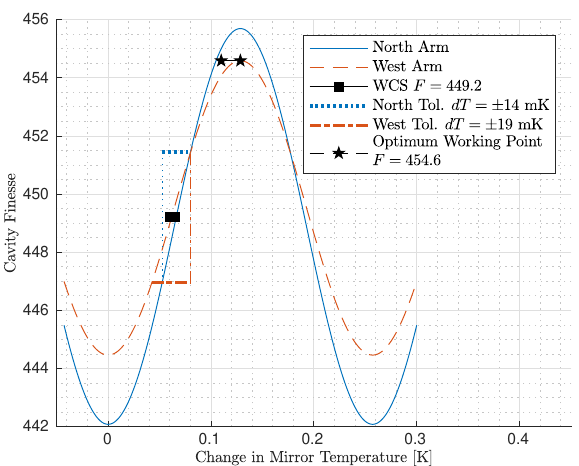
Figure 2. Finesse variation due to the etalon effect for the two arm cavities of Advanced Virgo. The temperature tolerance is calculated in the worst case scenario (WCS), where the slope of the curve is maximal. The reflectivity of the anti-reflective (AR) coating is 58ppm for the north arm and 32 ppm for the west arm. The reflectivity of the highly reflective (HR) coating, instead, is 0.98625 for the north arm and 0.98623 for the